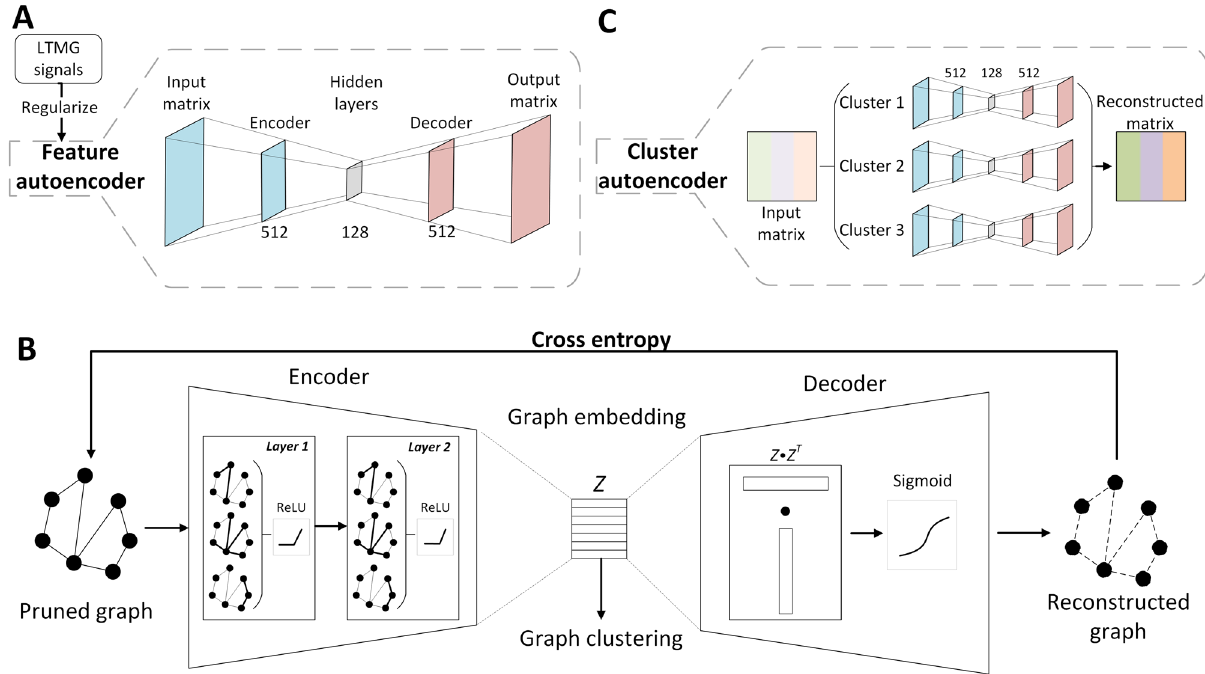
Fig. 2 The architecture of scGNN Autoencoders. a The feature autoencoder takes the expression matrix as the input, regularized by LTMG signals. The dimensions of the encoder and decoder layers are 512 × 128 and 128 × 512, respectively. The feature autoencoder is trained by minimizing the difference between the input matrix and the output matrix. b The graph autoencoder takes the adjacency matrix of the pruned graph as the input. The encoder consists of two layers of GNNs. In each layer, each node of the graph aggregates information from its neighbors. The encoder learns a low-dimensional presentation (i.e., graph embedding) of the pruned cell graph. The decoder reconstructs the adjacency matrix of the graph by dot products of the learned graph embedding followed by a sigmoid activation function. The graph autoencoder is trained by minimizing the cross-entropy loss between the input and the reconstructed graph. Cell clusters are obtained by applying k-means and Louvain on the graph embedding. c The cluster autoencoder takes a reconstructed expression matrix from the feature autoencoder as the input. An individual encoder is built on the cells in each of the identi fi ed clusters, and each autoencoder is trained individually. The concatenation of the results from all clusters is treated as the reconstructed